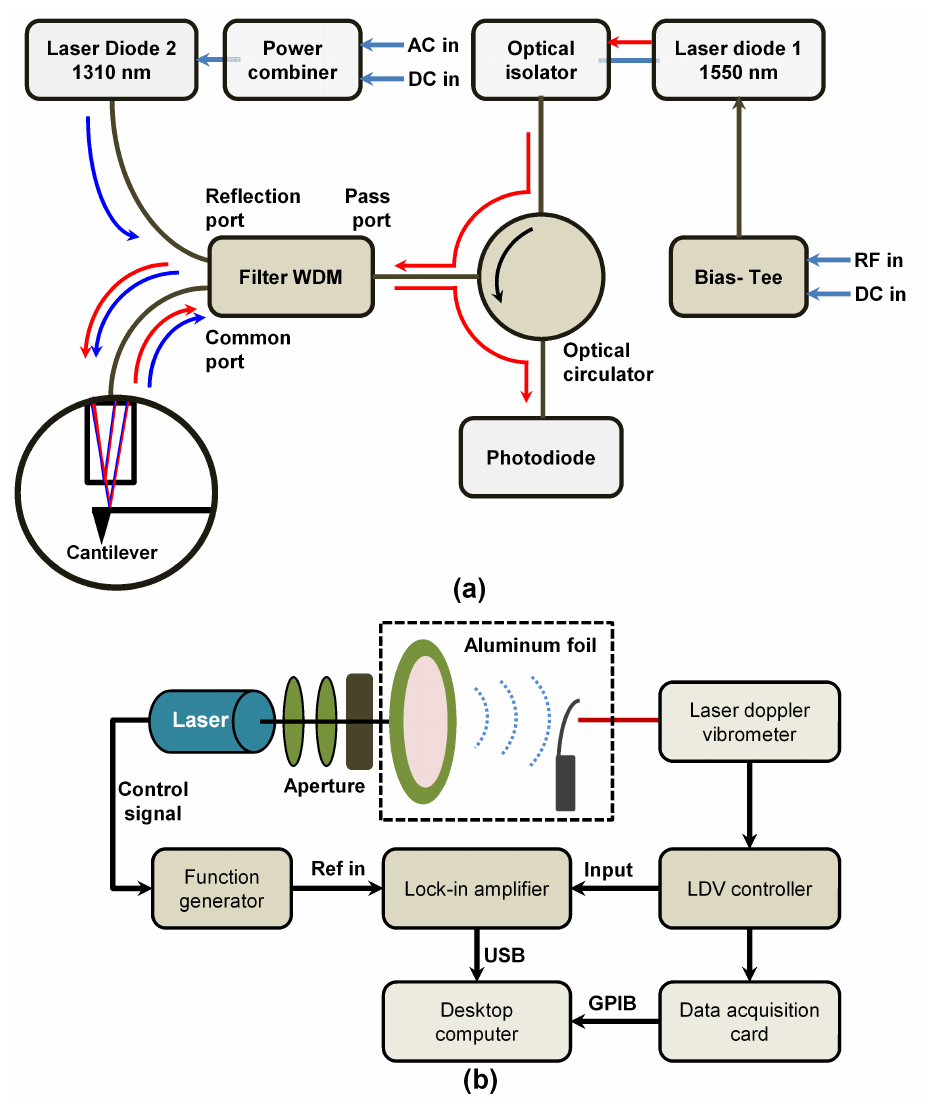
Figure 8. ( a ) A schematic of the optical excitation method for the microcantilever proposed by Miyahara et al. [187]. ( b ) Schematic of the experimental set-up for the laser induced photoacoustic excitation method for the microcantilever